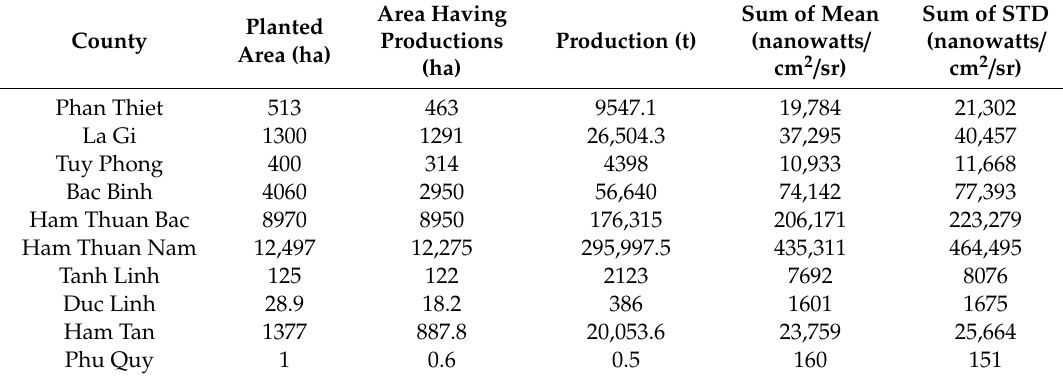
Table 1. Statistical data for dragon fruit from o ffi cial statistical yearbook and spatial calculation based on counties of Binh Thuan Province in